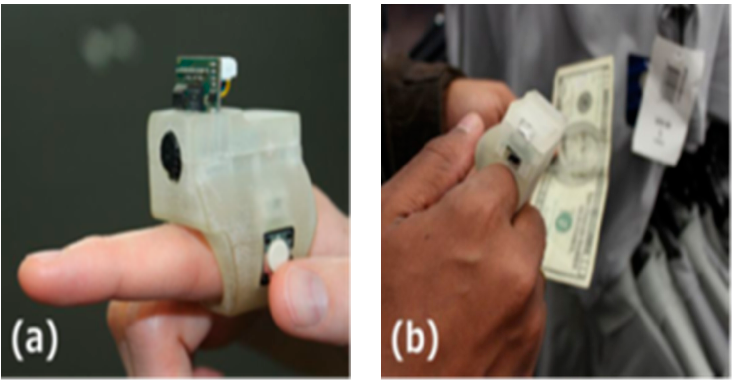
Figure 25. ( a ) The prototype of the EyeRing; ( b ) The process of EyeRing device of detecting and interaction application [48].